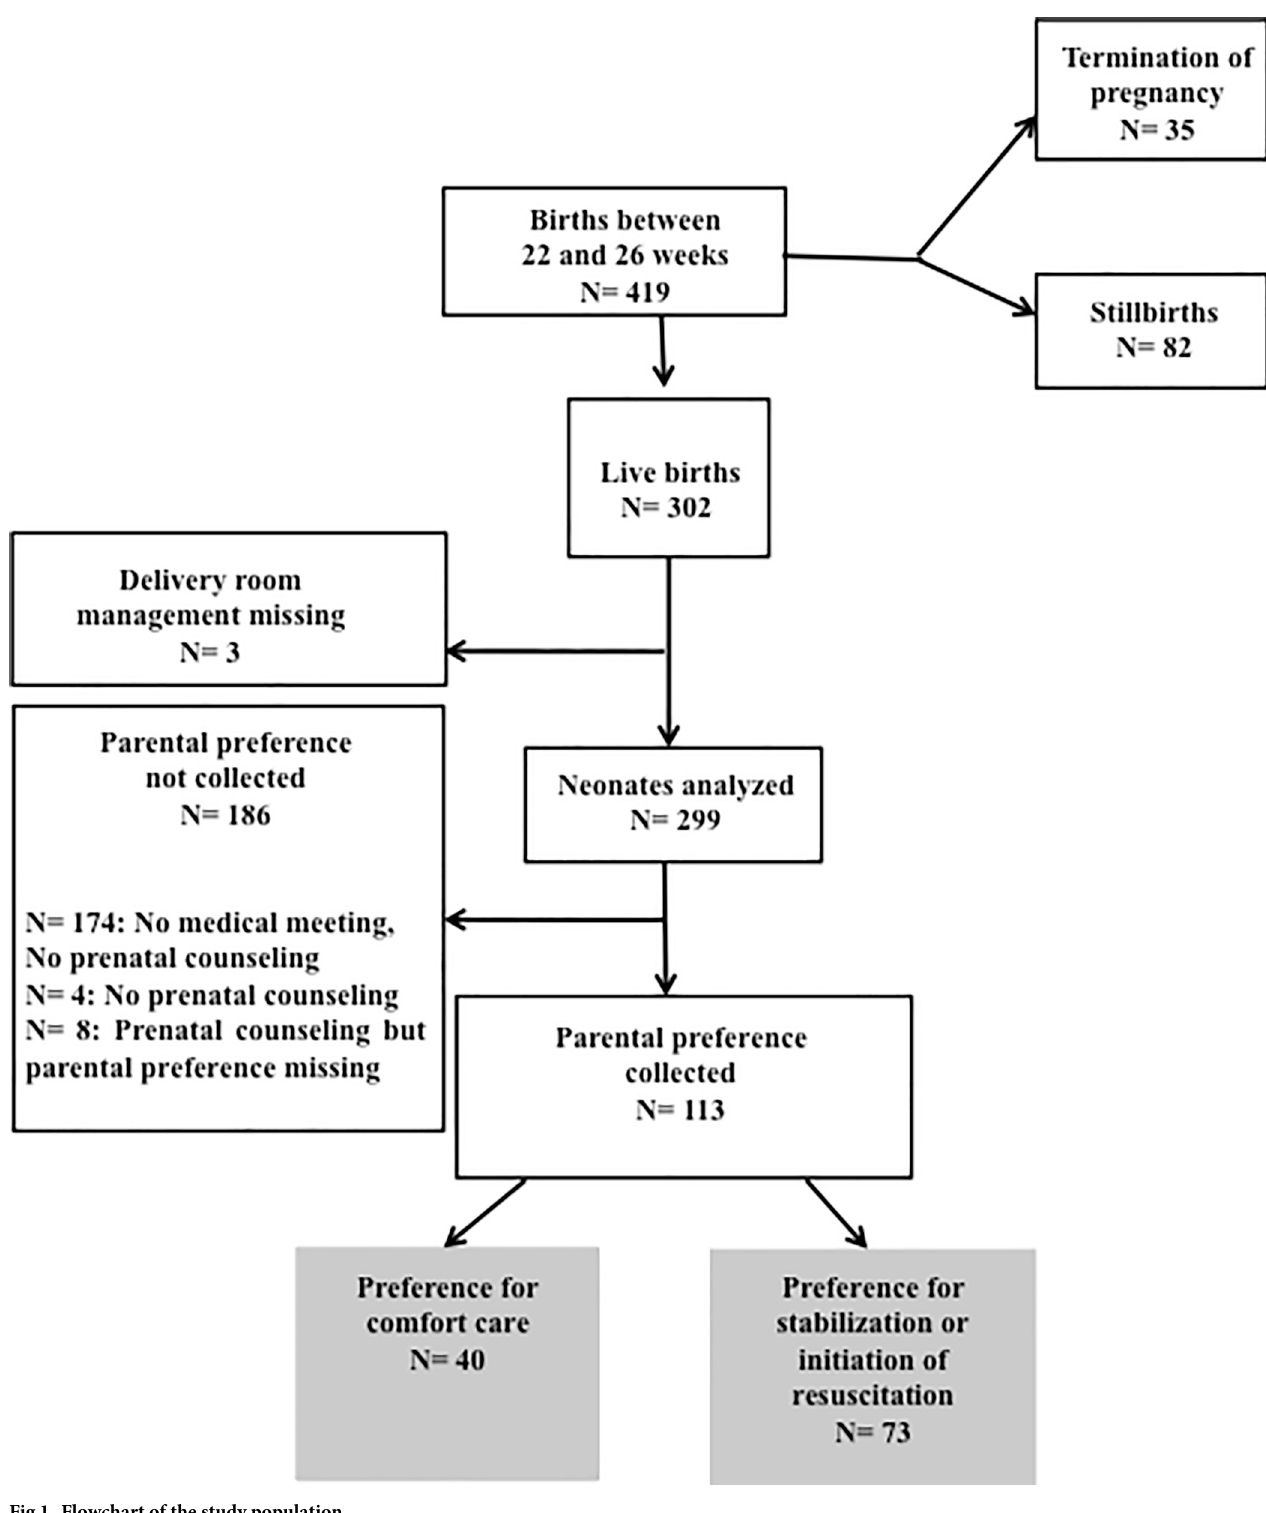
Fig 1. Flowchart of the study